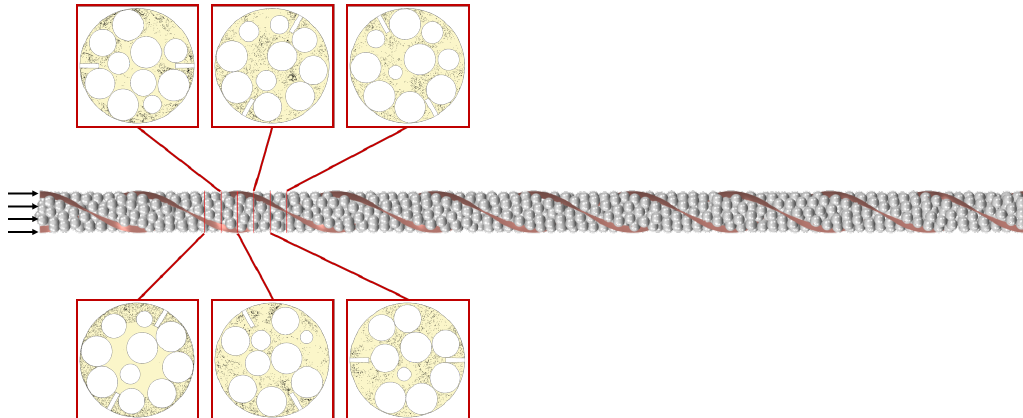
Figure 10. Radial profiles of the circumferentially and axially averaged absolute value of ( A ) axial and ( B ) tangential velocity, which are normed to the local interstitial velocity.